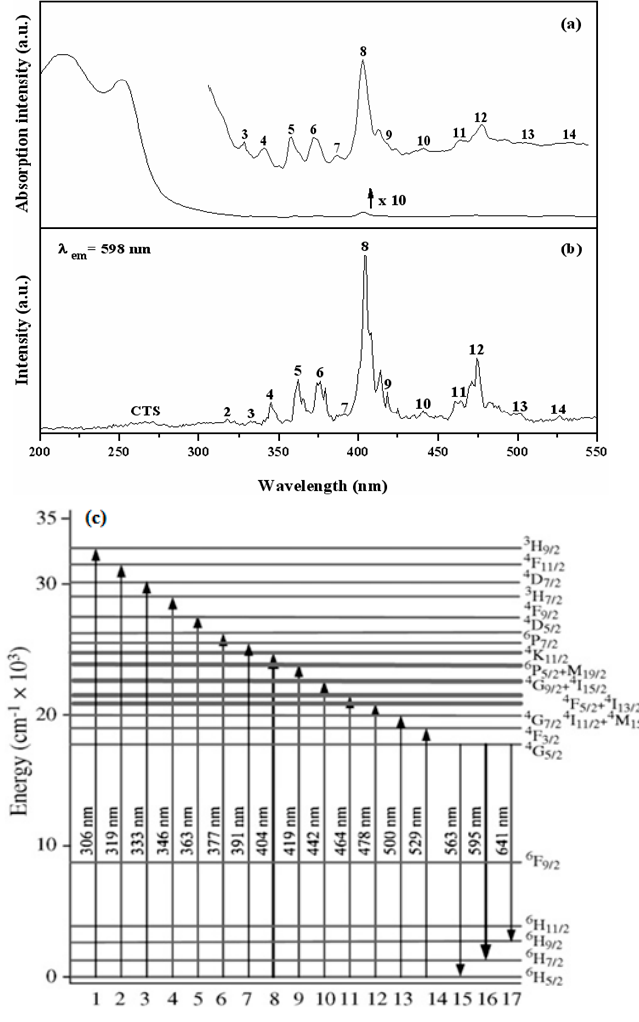
Figure 3. ( a ) Absorption and ( b ) excitation spectra ( λ em = 598 nm) for YInGe 2 O 7 doped with 3 mol % Sm 3+ ion calcined at 1300 °C for 10 h in air; and ( c ) is the energy level diagram of Sm 3+ ion.